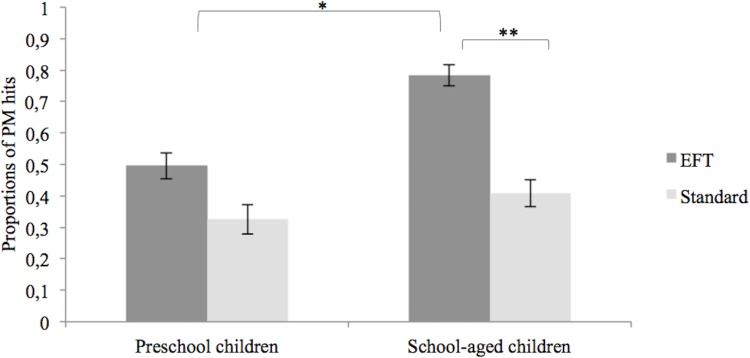
PM task performance for both age groups divided by encoding condition.Error bars depict standard errors of the mean.